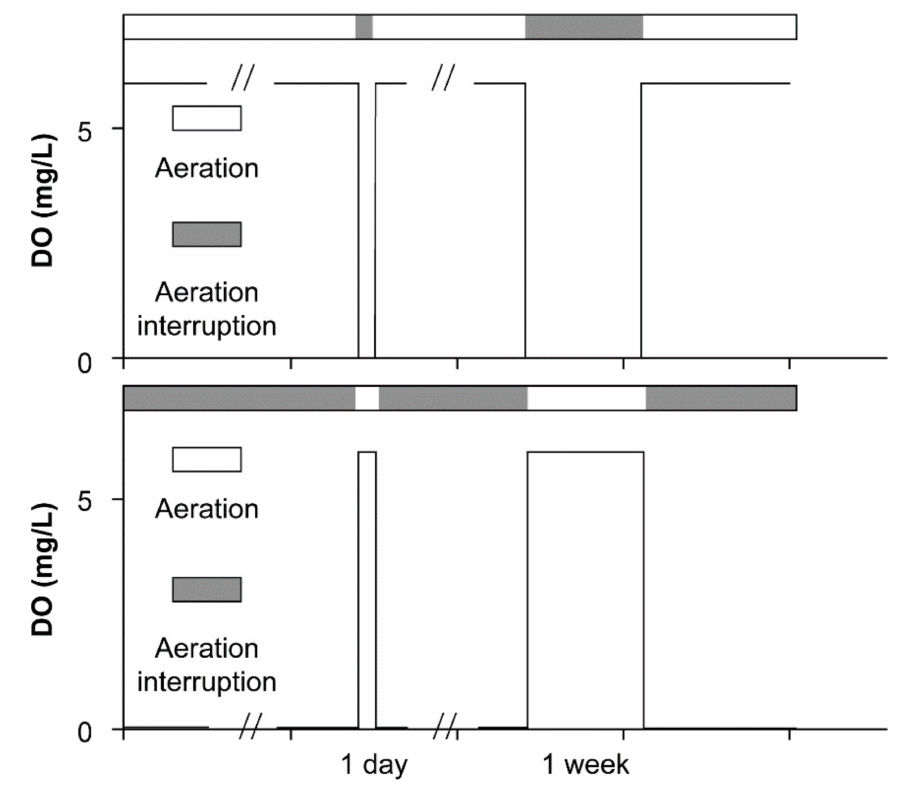
Figure 2. The designed conceptual modes for the transition between the aerobic and anaerobic states of the simulated